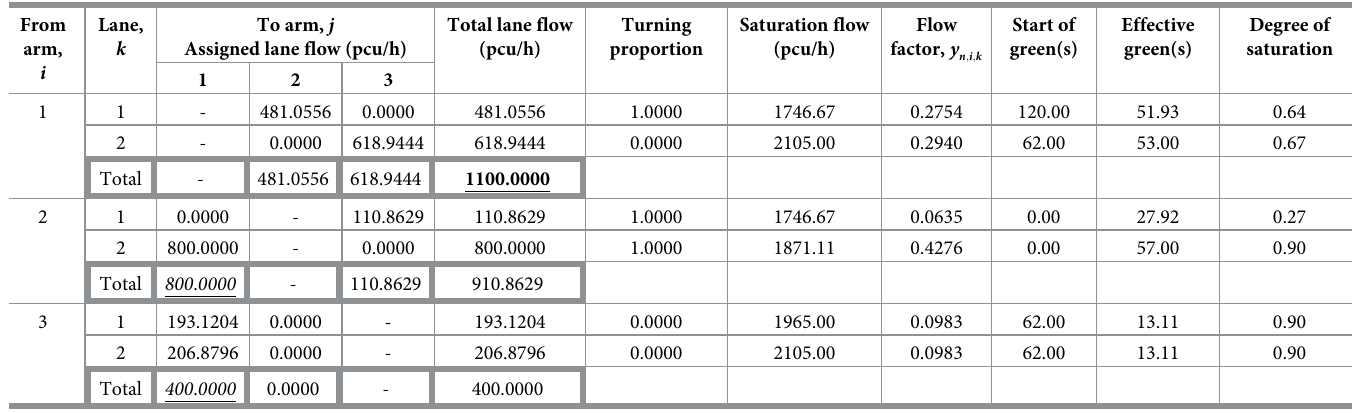
= z ¼ W = z ¼ 32 : 9 s (maximized), and z ¼ 1 = 120 : 0 . o ¼ 2 ; d ¼ 4 ; h o ; d ¼ 1 o ¼ 4 ; d ¼ 2 ; h o ; d ¼ 1